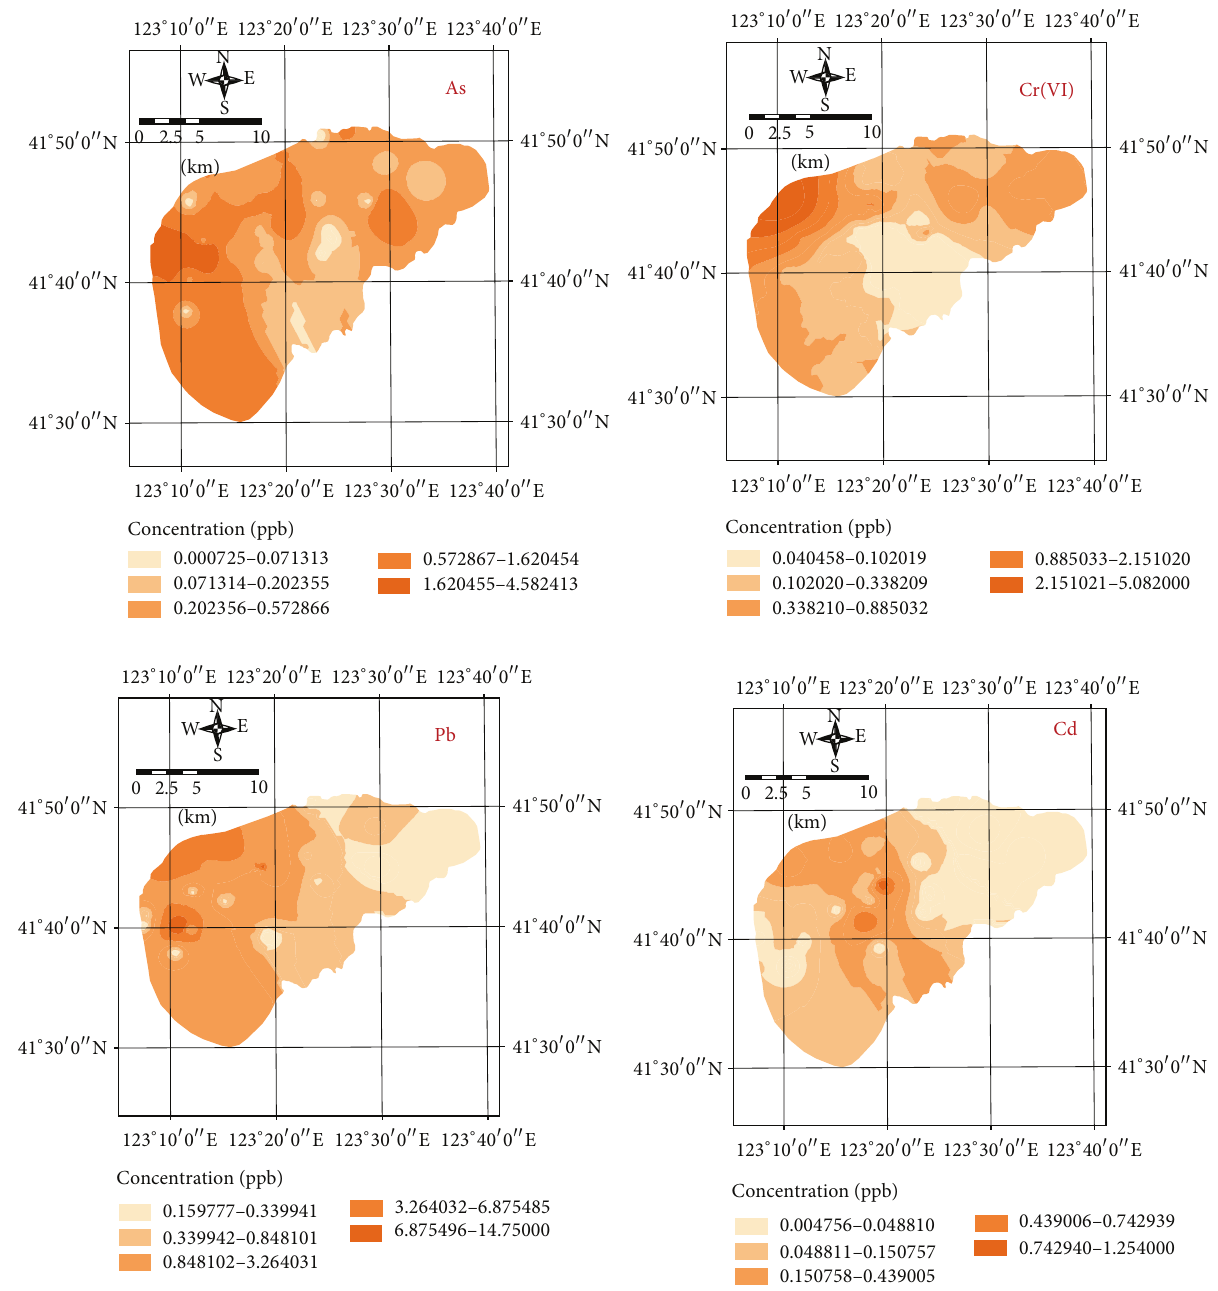
Figure 2: Distributions of As, Cr(VI), Pb, and Cd contents in